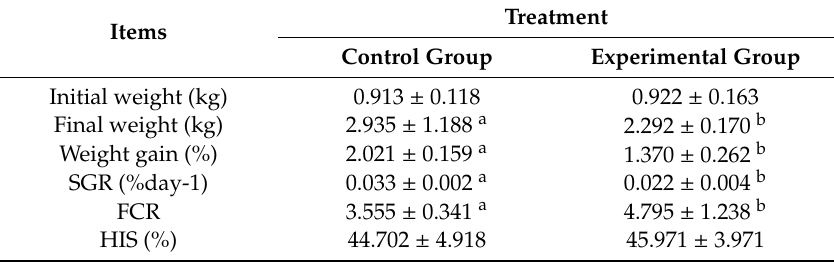
Table 2. Growth index changes of the control group and fasting caecotrophy